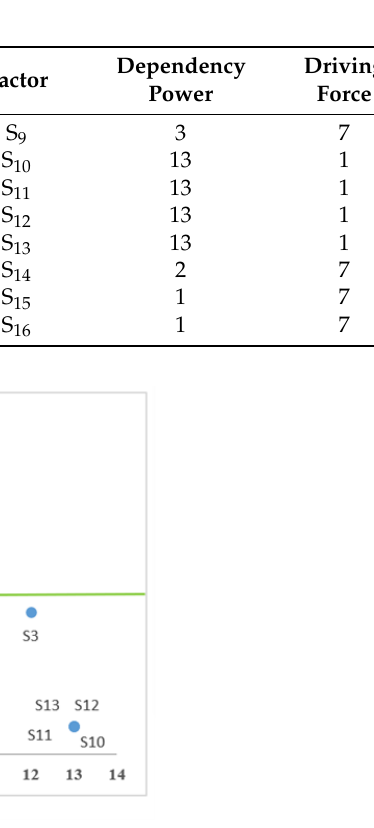
Figure 8. Driving-force-dependency power of factors influencing the brittleness of lean–green manufacturing systems in the context of Industry 4.0.